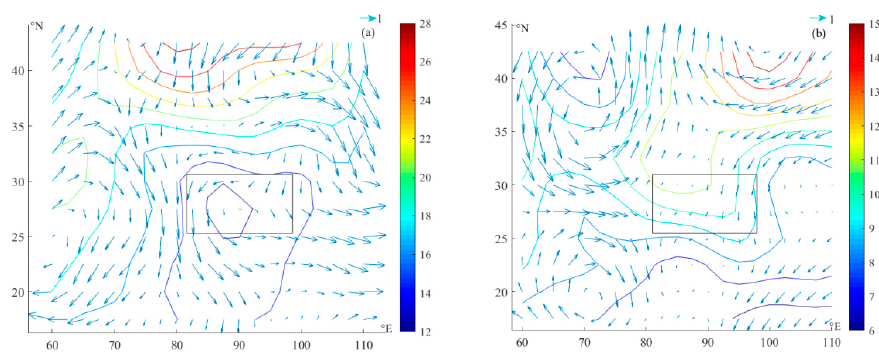
Figure 15. ( a ) The difference of geopotential height and wind speed (vector) at 500 hpa between